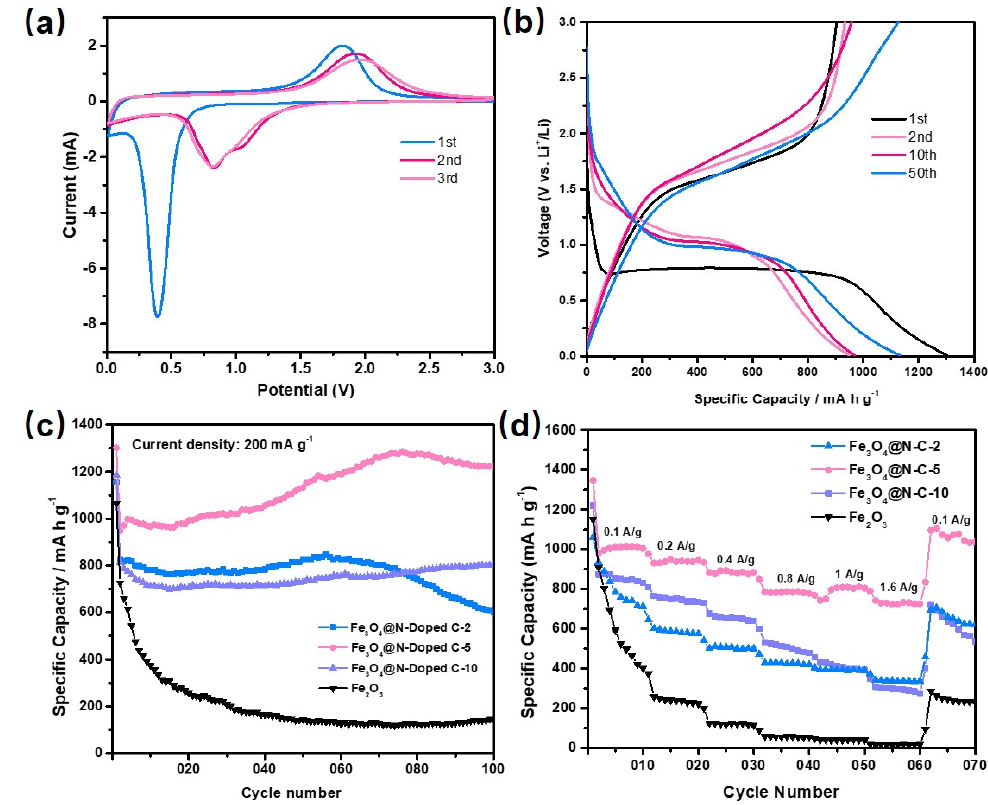
Figure 5. ( a ) Cyclic voltammetry curve of Fe 3 O 4 @void@N-doped C-5 composite; ( b ) representative charge–discharge curves of Fe 3 O 4 @void@N-doped C-5 composite; ( c ) 100 cycle diagrams of Fe 2 O 3 and Fe 3 O 4 @void@N-doped C- x ( x = 2, 5 and 10) composite at 200 mA g − 1 current density; ( d ) rate performance of cubic Fe 2 O 3 and Fe 3 O 4 @void@N-doped C- x composites ( x = 2, 5 and